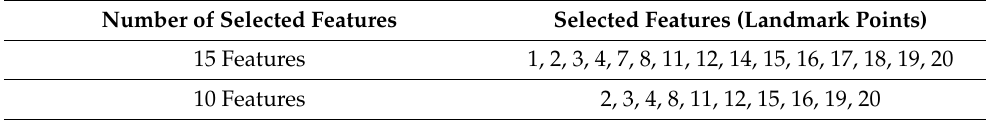
Table 2. Feature selection results.